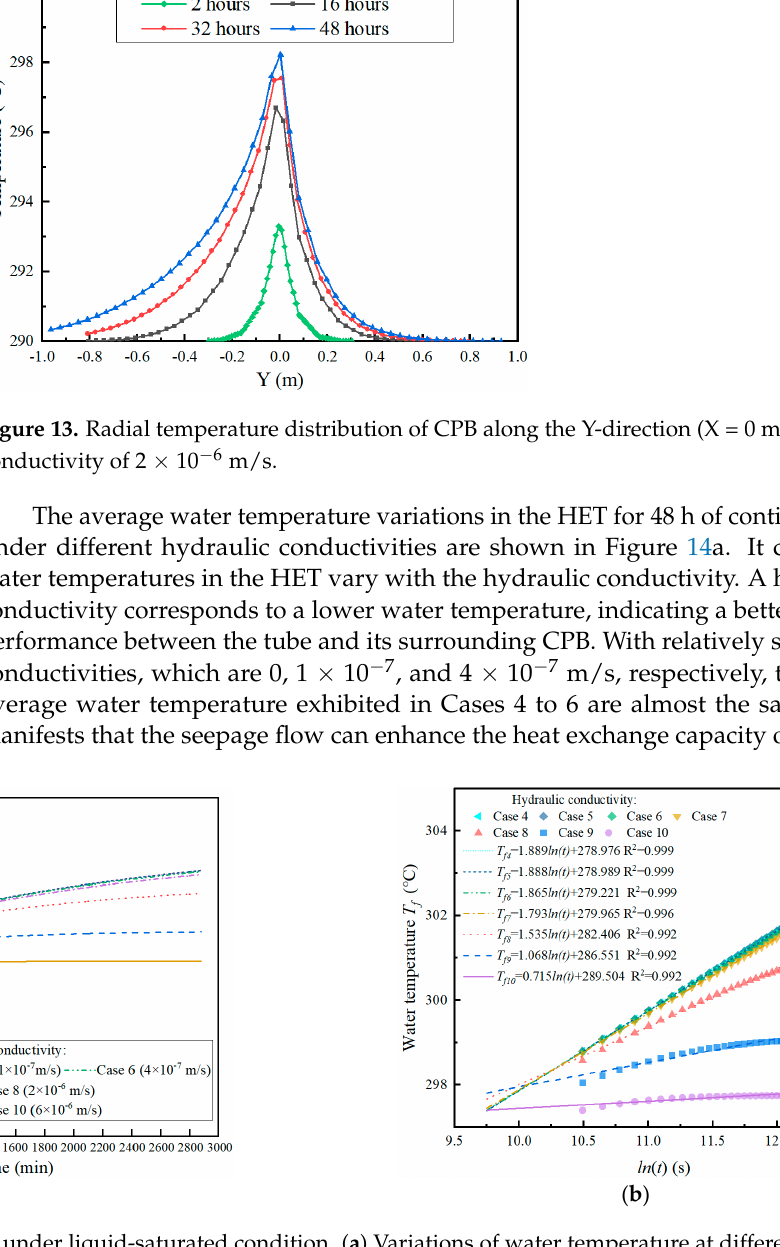
Figure 14. Water temperature under liquid ‐ saturated condition. ( a ) Variations of water temperature at different hydraulic conductivities; ( b ) regression curves of the water temperature.